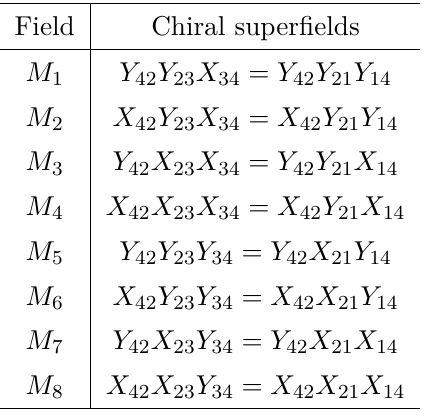
Table 3 . Generators of Q 1 , 1 , 1 in terms of fields in phase